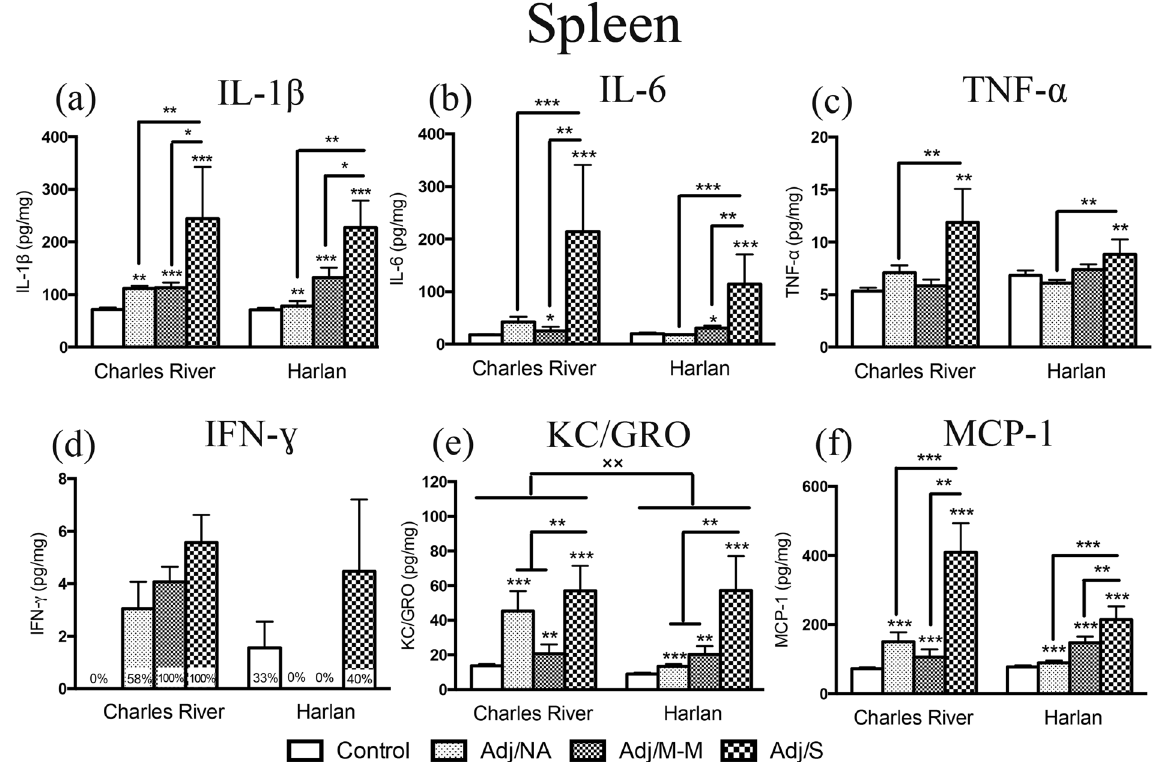
Figure 2. Cytokine levels in the spleen. Bars represent mean cytokine level ± SEM. Data are presented as pg cytokine/mg protein with statistical analysis conducted on Blom transformed (normalized) data. The presence of an asterisk ( * ) indicates a main effect of AA severity, with the comparison to the control group, unless otherwise indicated. The “ × ” symbol indicates a significant main effect of colony. Percentages on bars indicate the percent of rats with detectable cytokine levels, (within each AA severity state) and these data (d) were not analyzed statically due to non-normal distribution. Post hoc: * p < 0.05; ** / ×× p < 0.01; *** p < 0.001. Control: saline-injected; Adj/NA: no clinical signs of AA following CFA injection; Adj/M-M: mild-moderate AA, clinical score ≥ 1, < 8; Adj/S: severe AA, clinical score ≥